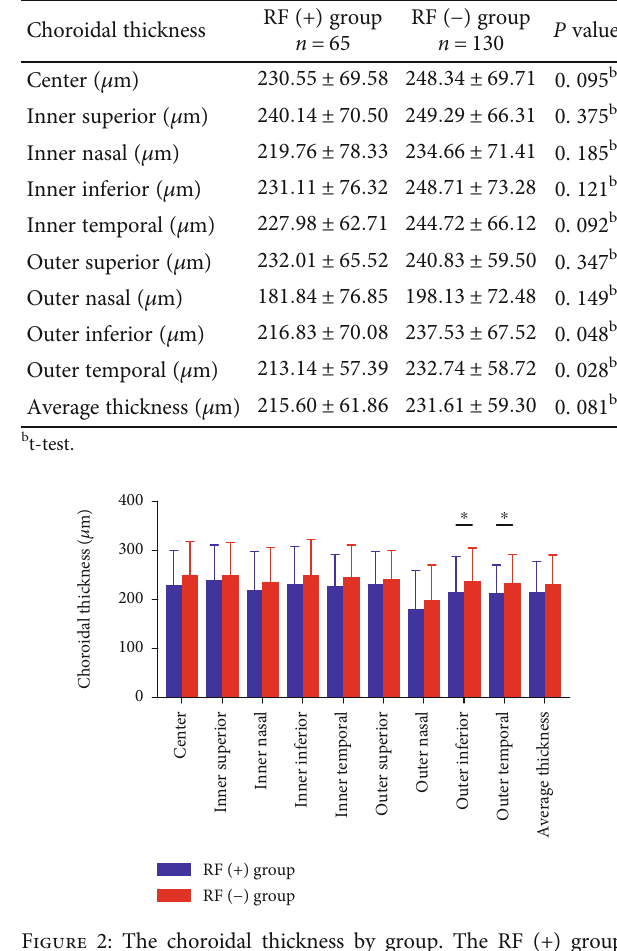
Figure 2: The choroidal thickness by group. The RF (+) group showed decreased choroidal thickness that achieved statistical signi fi cance only in the outer inferior and outer temporal sectors, as compared to the RF ( − ) group ( ∗ P < 0 : 05